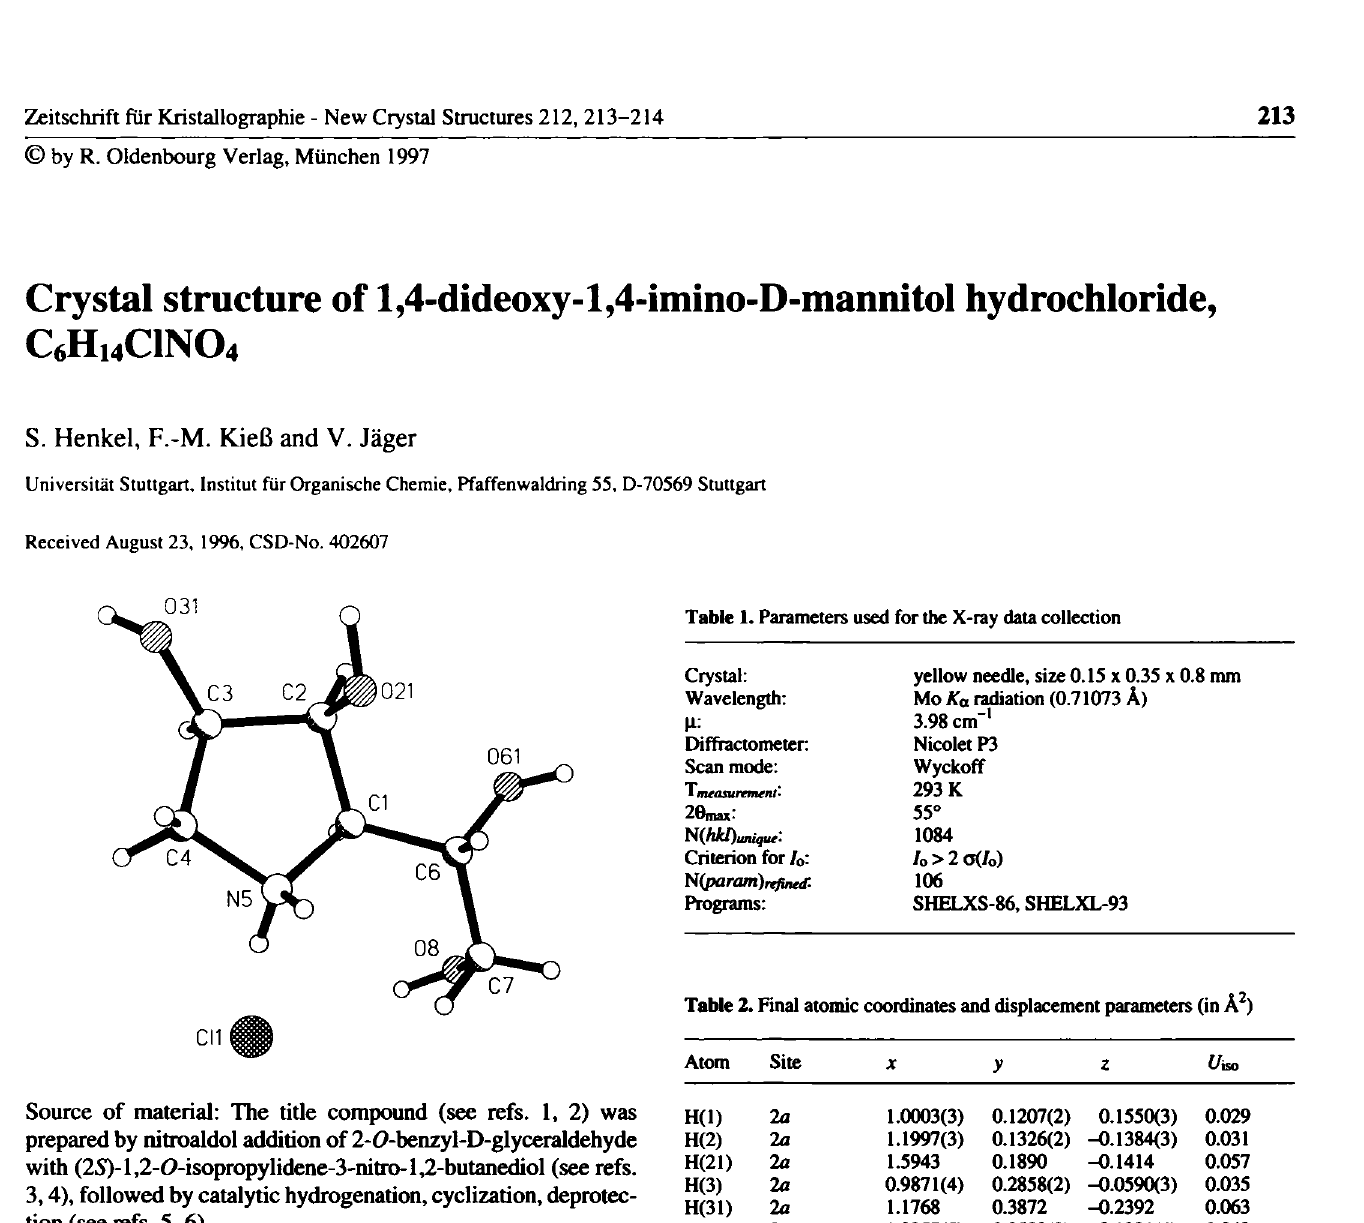
Table 2. Final atomic coordinates and displacement parameters (in Â 2 )